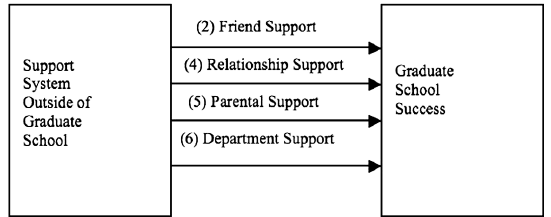
FIG. 3. 2A. What do female physics graduate students and professional Ph.D.s report about their support system outside of school and its impact on their graduate school success?